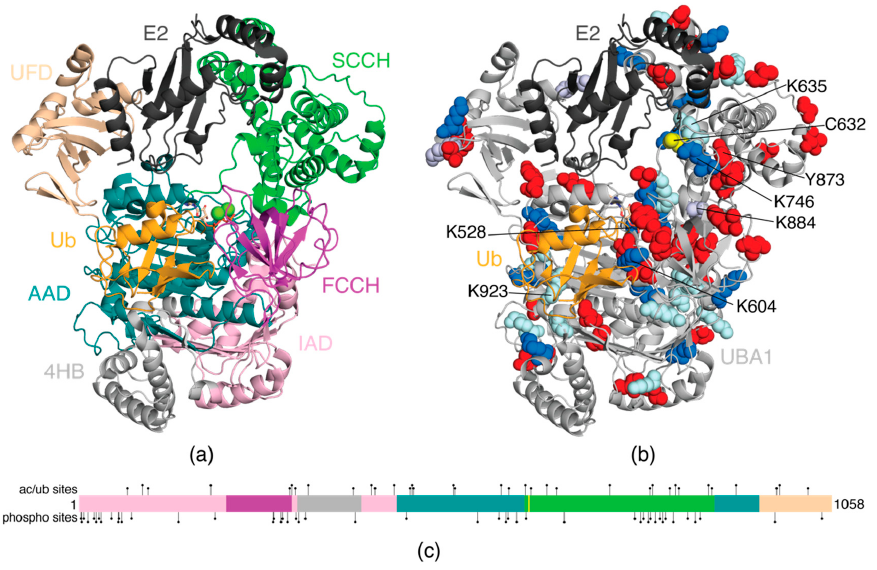
Figure 2. Cartoon model of the human E1 enzyme UBA1 in complex with the E2 conjugating enzyme, Ubc4 and ubiquitin. ( a ) Domains in UBA1 (PDB 6DC6) are indicated as 4HB (light grey), IAD (light pink), AAD (teal), FCCH (magenta), SCCH (green), UFD (wheat). The E2 enzyme (dark grey) and bound ubiquitin (orange) at the adenylation site are also shown. The E2 enzyme was modeled based on PDB coordinates 4II2 [98] and occupies a position consistent with other E1:E2 structures [99–101]. ( b ) The cartoon structure of UBA1 is shown in light grey, and the locations of acetylation or ubiquitination (blue), acetylation only (light purple), ubiquitination only (pale blue), and phosphorylation (red) sites in UBA1 are indicated. The catalytic cysteine (C632) is shown in yellow, and the E2 and Ub-adenylate are coloured as in ( a ). Only those PTM sites discussed in detail in the text are labelled here. ( c ) Linear domain organization of human UBA1 with colours matched to ( a ). The catalytic cysteine is indicated by a yellow bar, and all observed PTM sites in human UBA1 are indicated to the top (acetylation or ubiquitination) and bottom (phosphorylation) of the schematic.